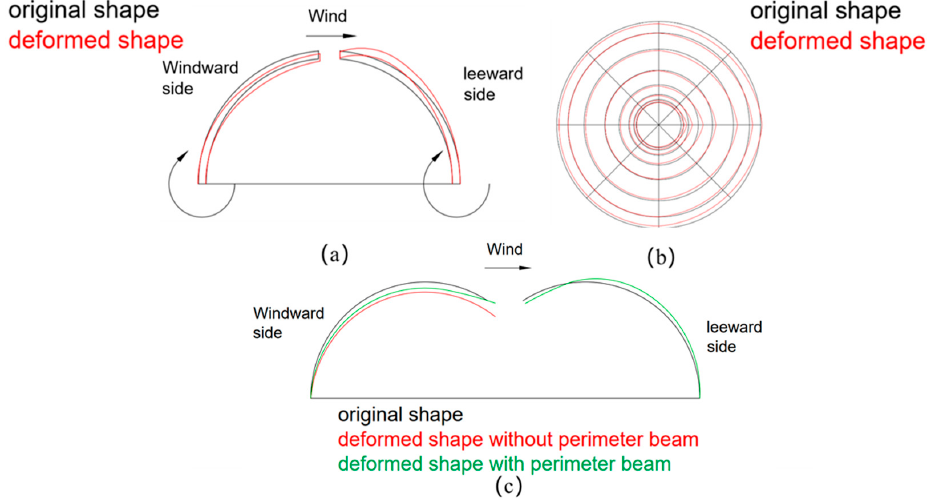
Figure 7. The deformation of the structure under lateral loading: ( a ) load direction demonstration; ( b ) top view of deformation shape; ( c ) front view of deformation shape. ( b ) top view of deformation shape; ( c ) front view of deformation